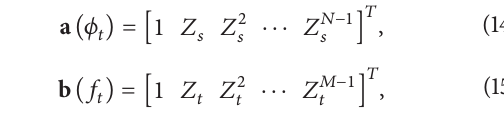
ensure that the training data are highly related with the clutter cell under